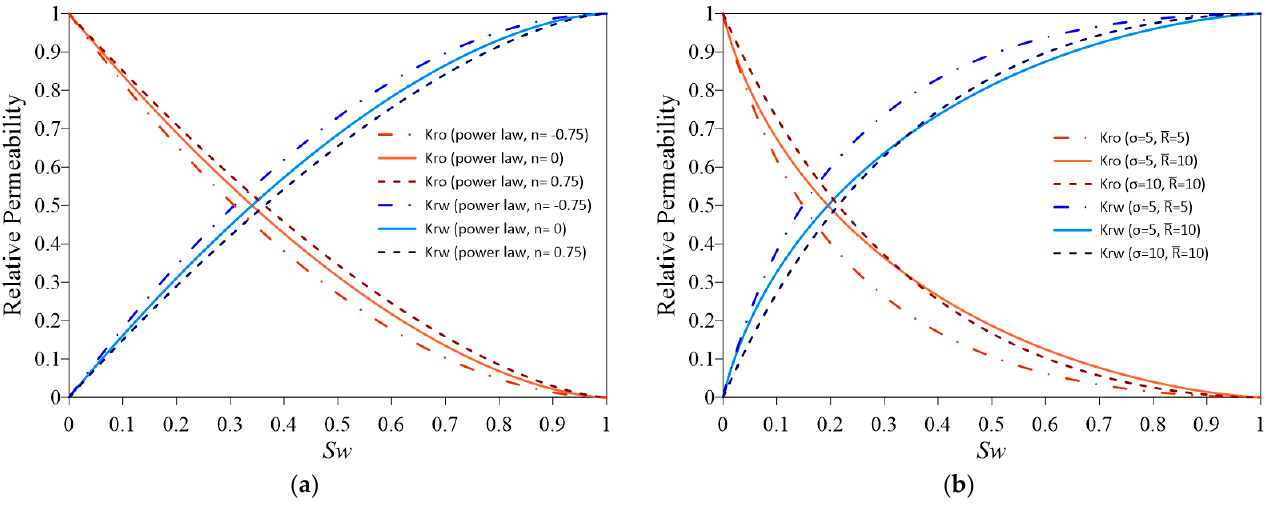
Figure 6. Oil–water relative permeability curves with different PSD functions. ( a ) Power law PSD functions; ( b ) log-normal PSD functions.